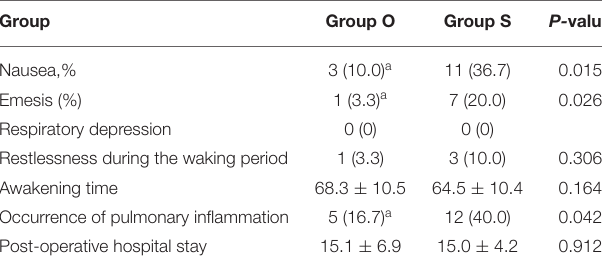
TABLE 3 | Comparison of adverse events related to analgesia, pulmonary inflammation and post-operative hospital stay between the two groups [cases (%)].